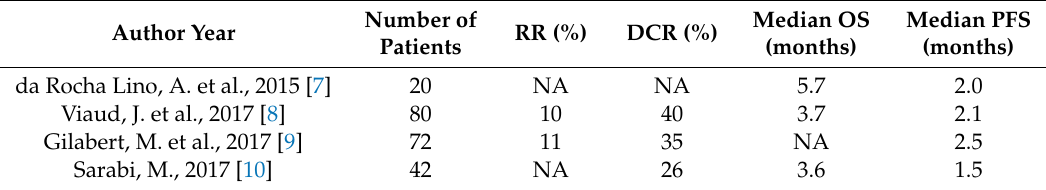
Table 7. Previous studies about second-line gemcitabine (GEM) alone after failed